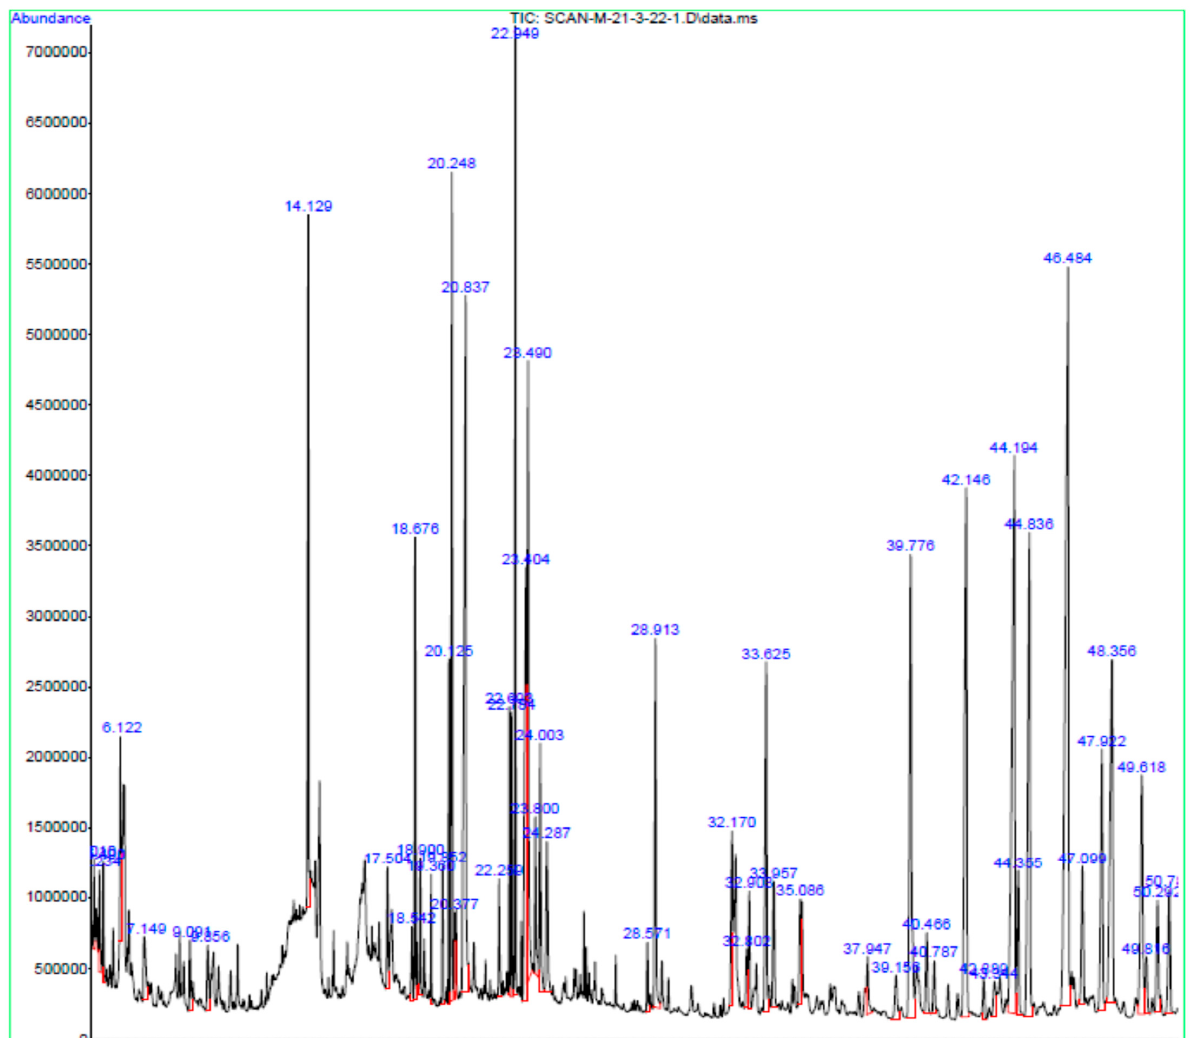
Figure 2. GC-MS chromatogram of C. tuberculata extract. Table 2. GC-MS analysis of C. tuberculata extract.